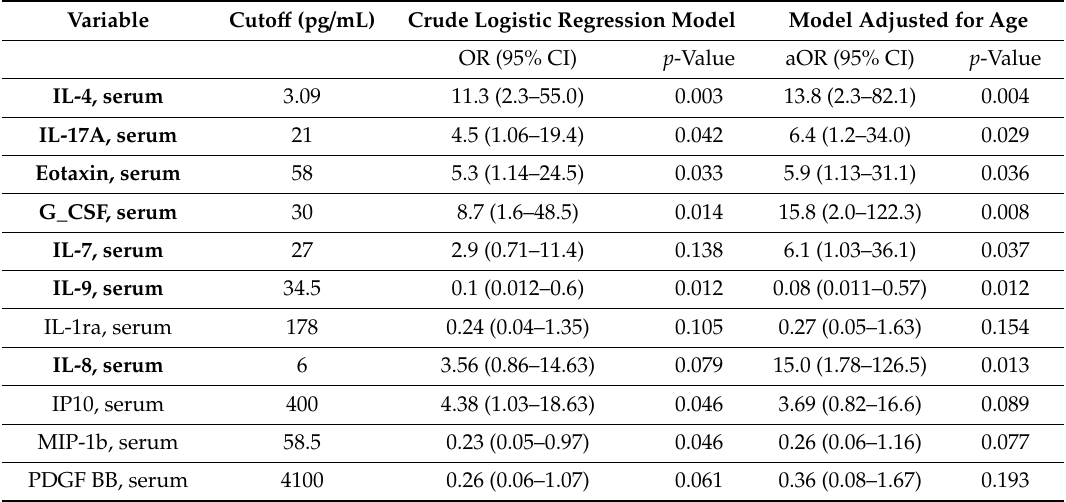
Table 2. Association between the TA-specific responses and the cytokine data. Results from crude and age-adjusted logistic regression models for responses according to the dichotomized cytokine data. Each cytokine was considered individually as a continuous variable and categorized using the optimal cutoff for the prediction of a TA-specific response. Odds ratios are provided for values below the respective optimal cutoffs (reference group “≥ cutoff” with OR = 1).